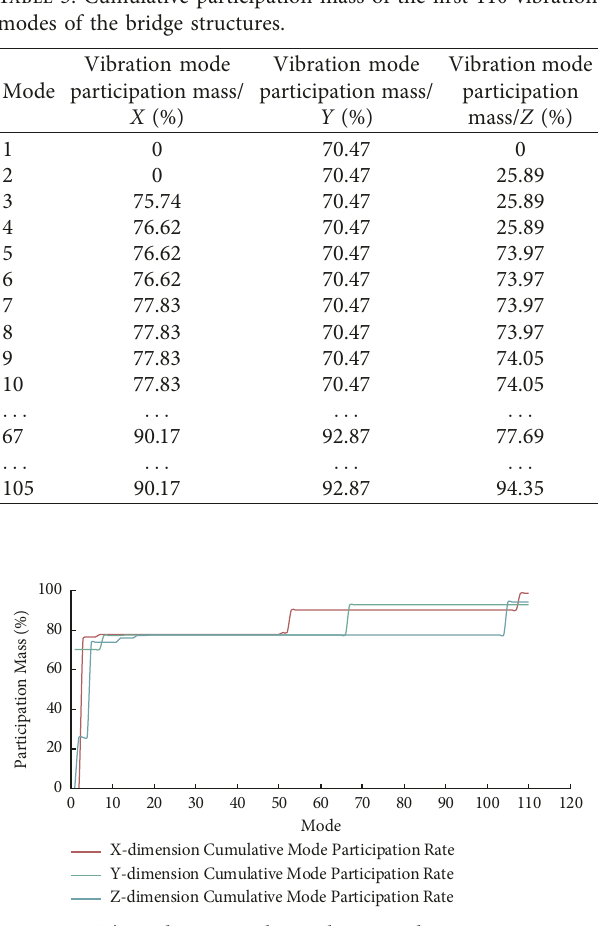
Figure 11: Three-dimensional cumulative mode participation rate.